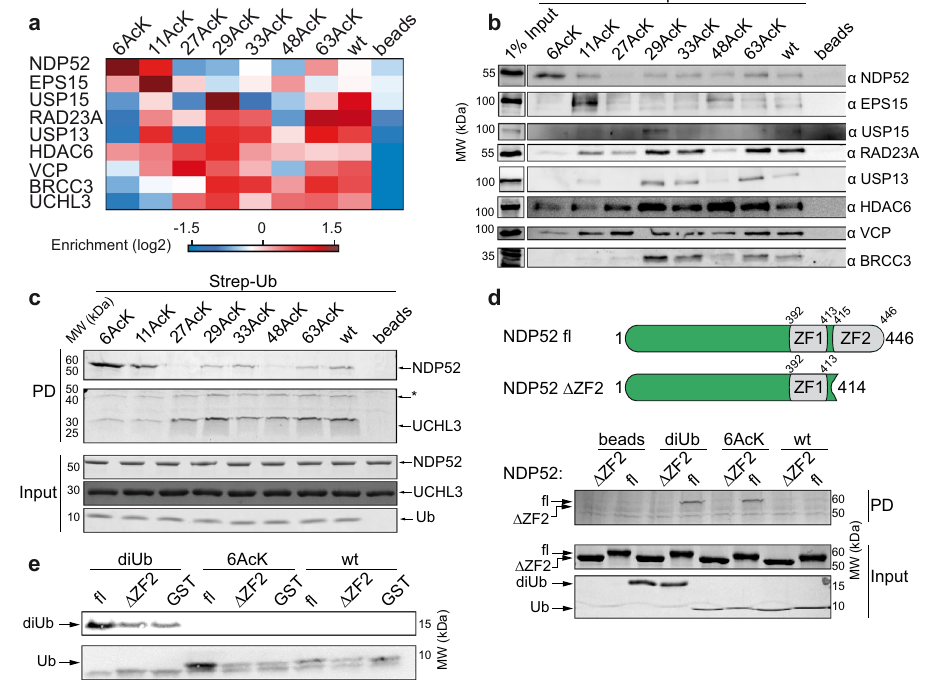
Fig. 6 | NDP52 binds selectively to Ub 6AcK. a Selected interactors of acetylated Ubvariantswithadistinctbindingpattern.Redindicatesenrichment,whereasblue indicates lack of enrichment. b Con fi rmation of interactions by western blot ana- lysis. 20% of the elution fraction of the af fi nity enrichment were subjected to western blot analysis with antibodies speci fi c for the indicated proteins. Input represents 1% of the HEK293T cell extract used for af fi nity enrichment. c Veri fi cation of interactions by in vitro binding assays using recombinant NDP52 and UCHL3 and the bait molecules indicated. Binding reactions were analyzed by SDS-PAGEfollowedbyCoomassiebluestaining(PD).10%oftheproteinsusedinthe binding assay are shown in the lower panel (Input). Asterisk indicates the running position of an UCHL3-Ub adduct that was recently described 80 . d In vitro binding assay using Strep-tagged versions of nonmodi fi ed Ub (wt), Ub acetylated at K6